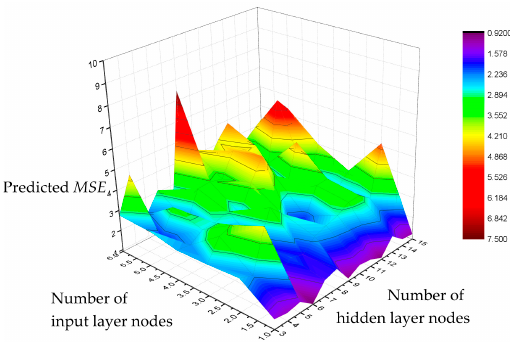
Figure 4. Comparison of prediction indicators.